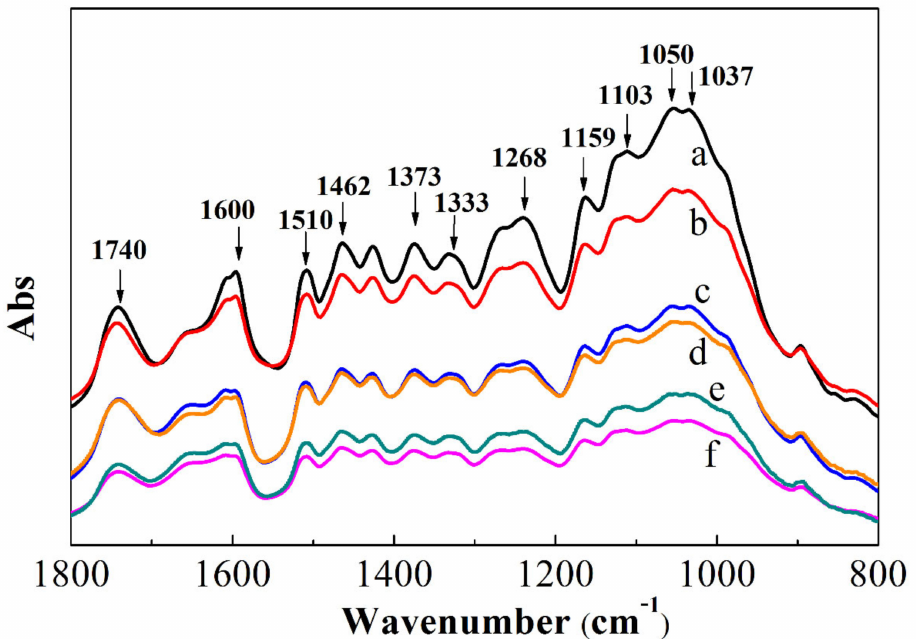
Figure 2. FTIR spectra of (a, b) undecayed WFMRC, (c, e) T. versicolor -exposed WFMRC, and (d, f) G. trabeum -exposed WFMRC: (a, e, f) untreated (control) WFMRC and (b, c, d) CuAz-treated (AI)